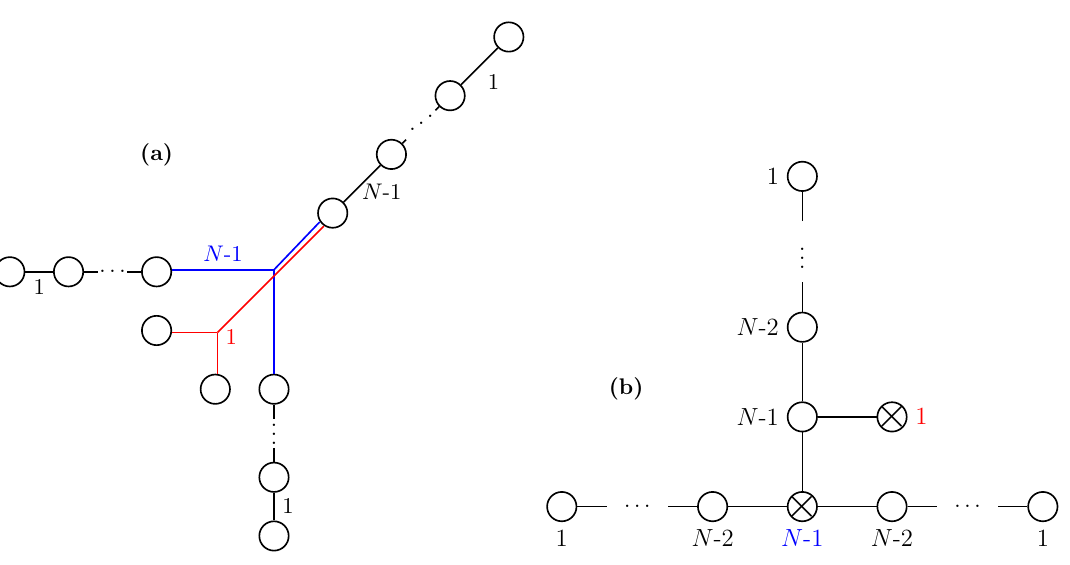
Figure 28 . (a) Brane web and (b) magnetic quiver for the (cid:12)rst descendant of T N